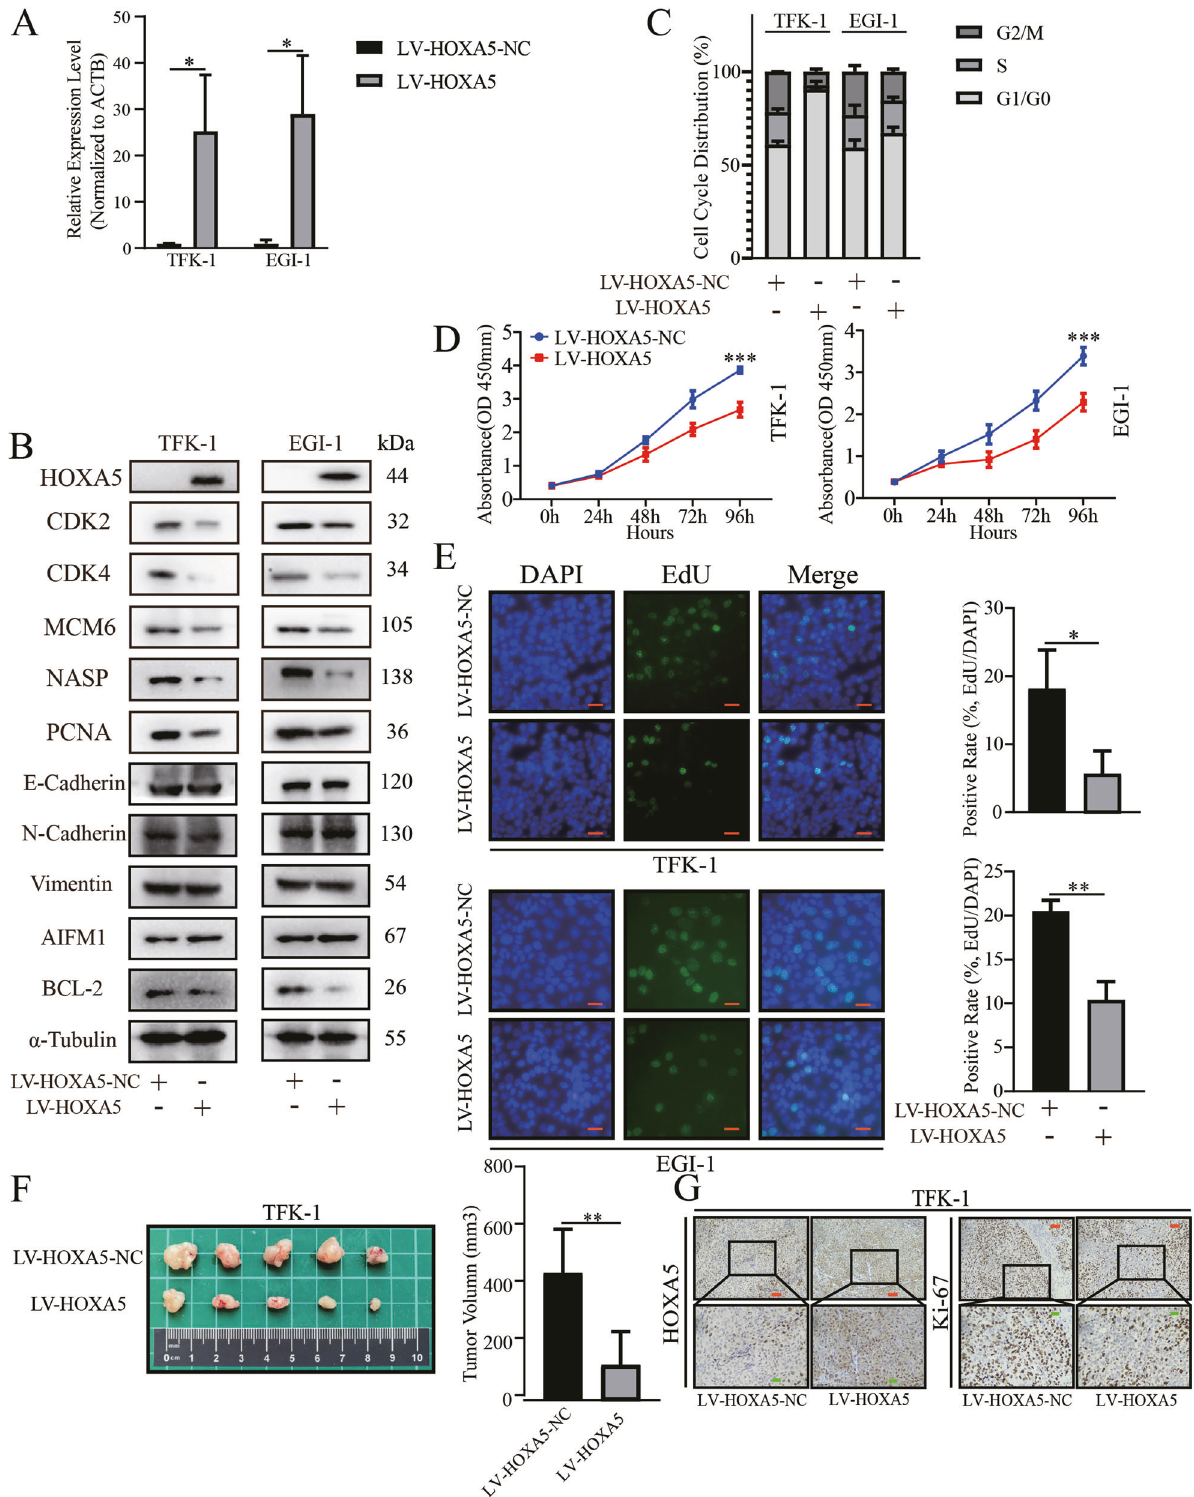
Fig. 3 HOXA5 overexpression attenuates the malignant behaviors of ECCA cells. A , B RT-qPCR and Western blot analyses validated HOXA5 overexpression, which reduced the mitosis-related gene expression in ECCA cells. HOXA5 overexpression did not alter the EMT-related gene expression, but increased AIFM1, and decreased BCL-2 expression in ECCA cells. C HOXA5 overexpression induced cell cycle arrest in G1/G0 phase. D , E HOXA5 overexpression inhibited the proliferation of ECCA cells. F HOXA5 overexpression decreased the tumor volumes in mice. G Immunohistochemistry analysis of HOXA5 and Ki67 expression in xenograft tumors from nude mice. Data are representative images from three separate experiments. * P < 0.05. ** P < 0.01. *** P < 0.001. Orange bar, 50 μ m. Green bar, 20 μ m.